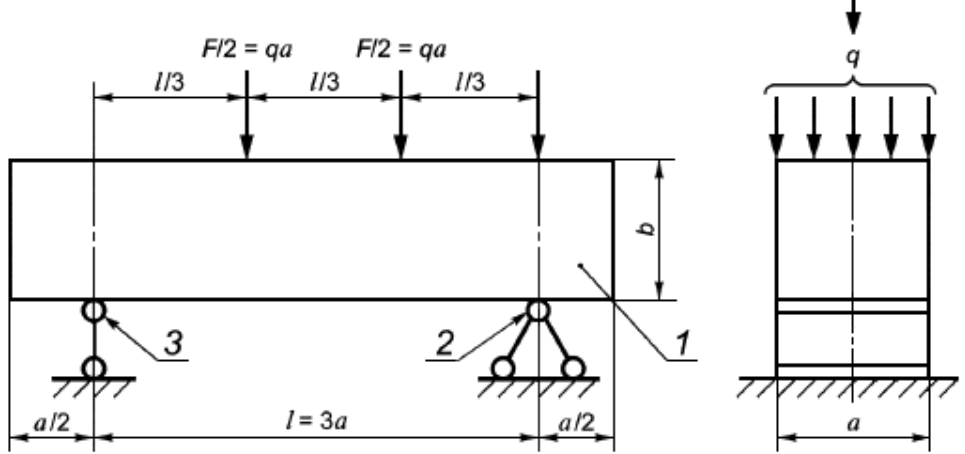
Figure 4. Flexural tensile test setup (a—width and height of the sample; F—load; q—distributed load; l—span; 1—sample; 2—articulated fixed support; 3—articulated-movable support).